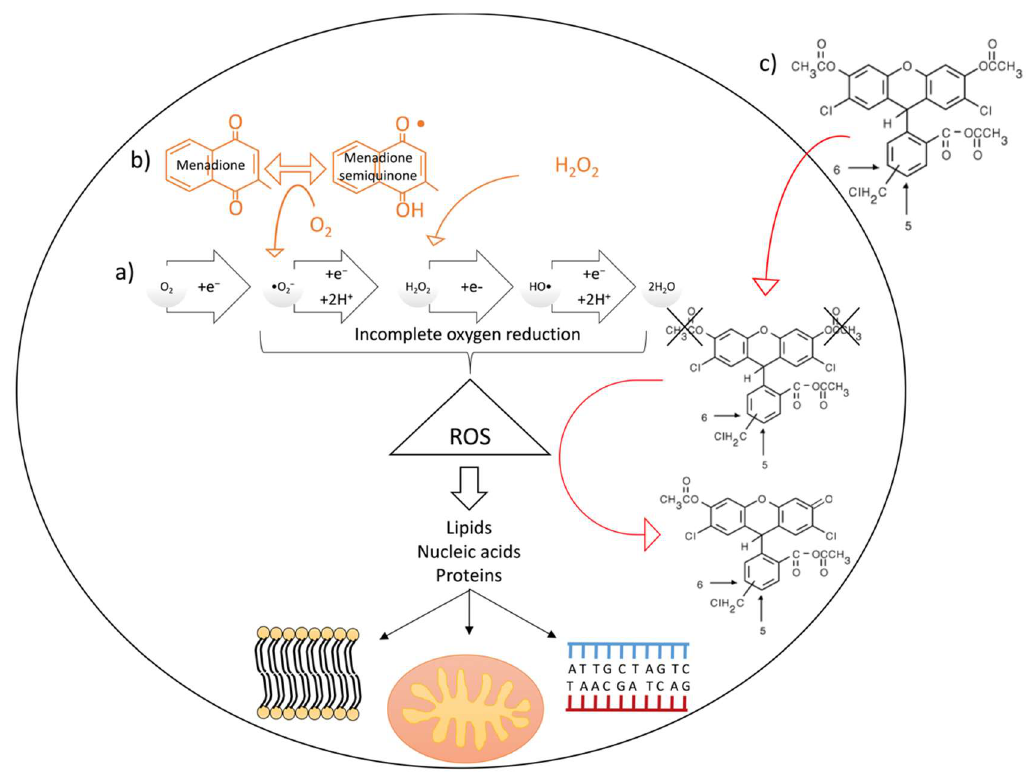
Figure 1. ( a ) Naturally occurring intracellular reactive oxygen species (ROS) production and consequences on cellular components (cell membranes, mitochondria and DNA); ( b ) H 2 O 2 and menadione contribution to intracellular ROS accumulation (orange arrows indicate how these molecules contribute to the incomplete reduction of oxygen) and ( c ) CM-H 2 DCFDA ROS-sensitive probe mechanism of action. Red arrows indicate movement of the probe from the extracellular to the intracellular space (up) and contribution of ROS to the oxidation of the probe (down).